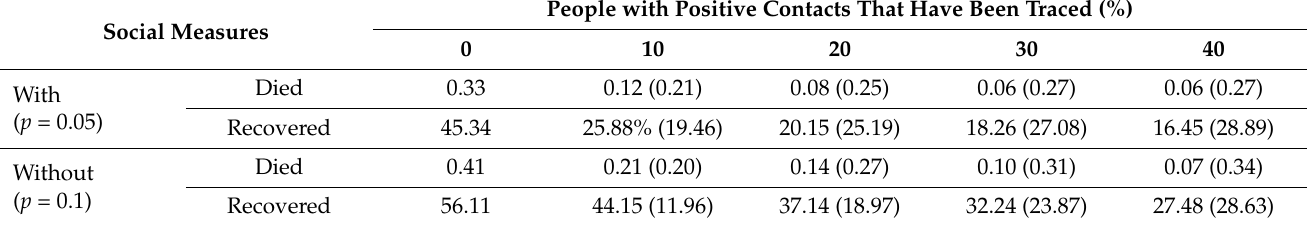
Table 7. Number of tests performed based on the percentage of contacts traced.